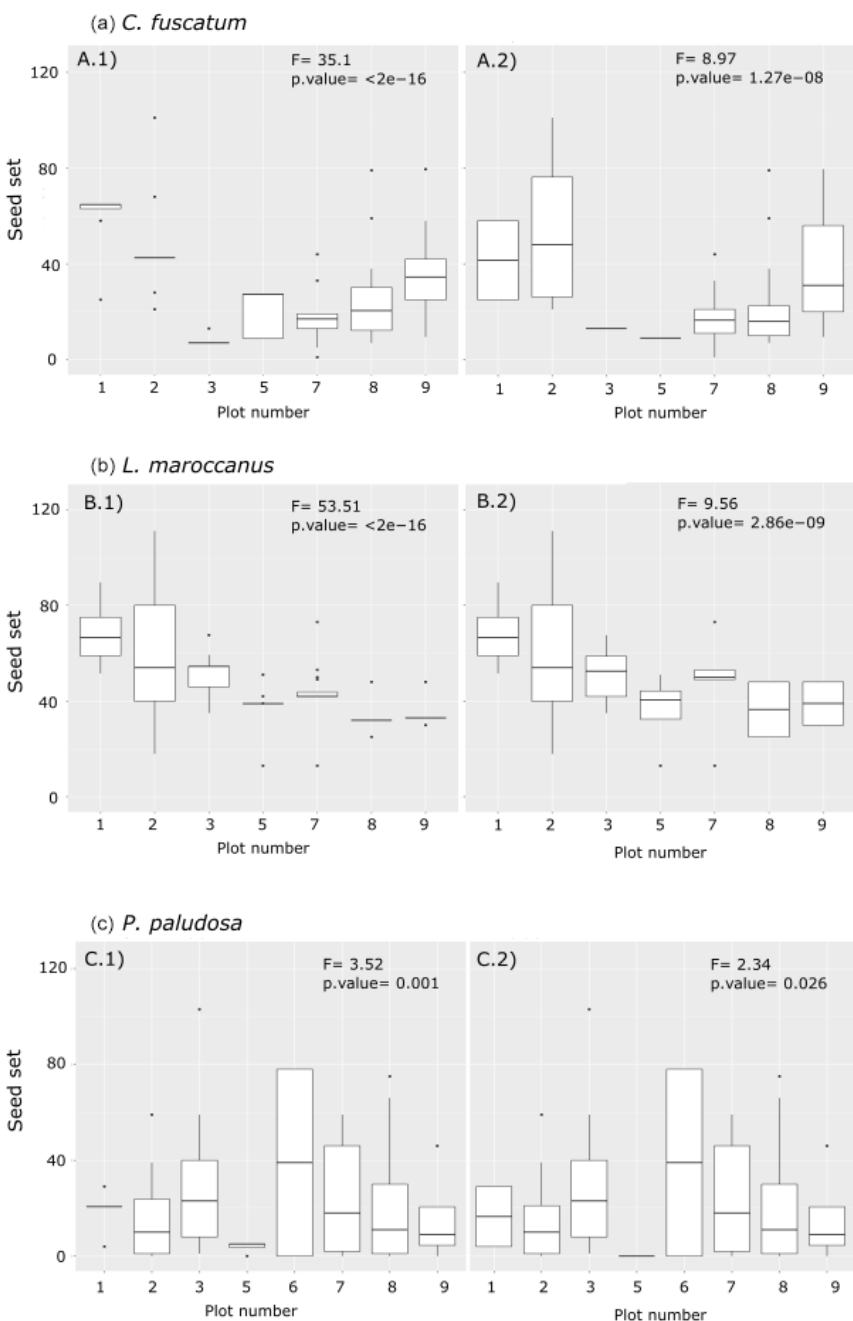
Figure A3. Differences between the number of the seed sets per individual per plot and per species ( a : C. fuscatum ; b : L. maroccanus ; c : P. paludosa ). The left column shows the seed set with the missing data that were filled with the average of the seed set per plot, while the right column shows the seed set data collected in the field. Each panel shows the F value and the p value of the ANOVA test. These results indicate that filling the missing data with the average of the plot, although not ideal, maintains the variability across plots. For a better interpretation of this figure, we have delimited the y axis to a maximum of 125 seed sets; there are four points omitted in the